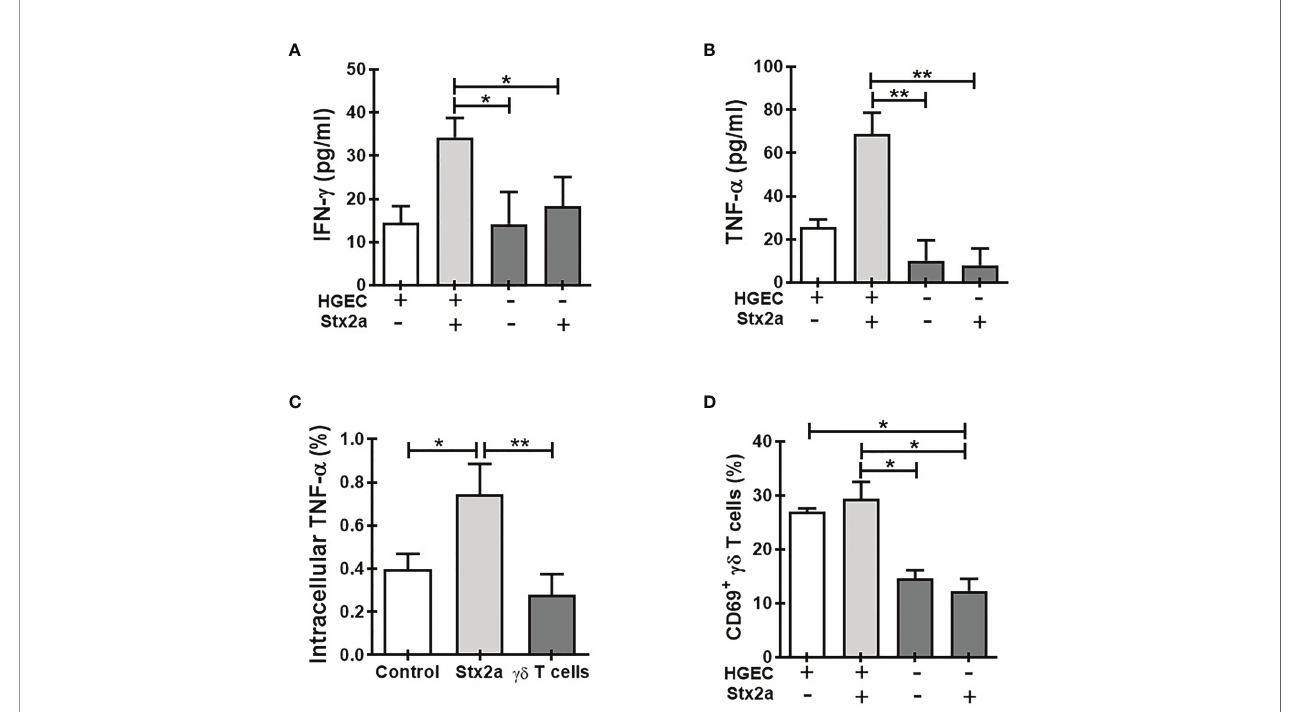
FIGURE 1 | Co-culture of gd T cells with Stx2a-stimulated HGEC induce its activation. gd T cells were cultured overnight at 37°C in the absence or presence of HGEC, treated or not previously with Stx2a (0.01 ng/ml, 24 h). gd T cells were resuspended in M199 supplemented with 10% FBS. After culture, supernatants and cells were collected. (A) IFN- g and (B) TNF- a production in supernatants was measured by ELISA, n=7 and n=5, respectively. Biological replicates. Kruskal-Wallis test, with Dunn ’ s multiple comparisons test. (C) Intracellular cell staining of TNF- a in gd T lymphocytes. Control (open bar) represents gd T cell culture with HGEC non-treated with Stx2a, n=8. Biological replicates. Kruskal-Wallis test, with Dunn ’ s multiple comparisons test. (D) CD69 expression in gd T cells, was analyzed by fl ow cytometry, n=5. Biological replicates. Kruskal-Wallis test, with Dunn ’ s multiple comparisons test. Results are shown as the mean ± SEM, * p < 0.05, ** p <